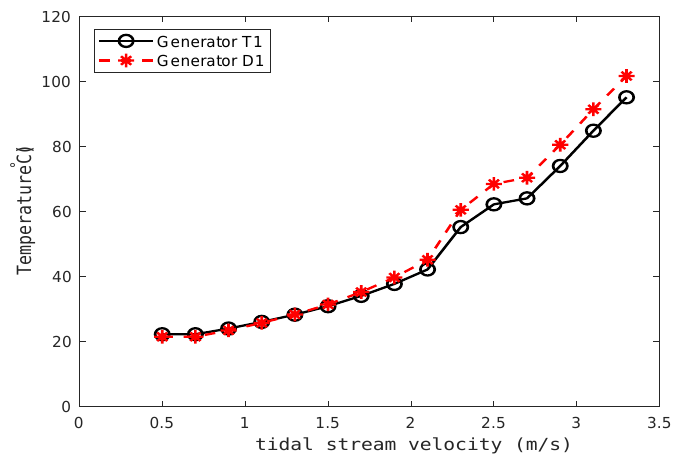
Figure 20. Mean junction temperature of Generator Side Converter Diode.